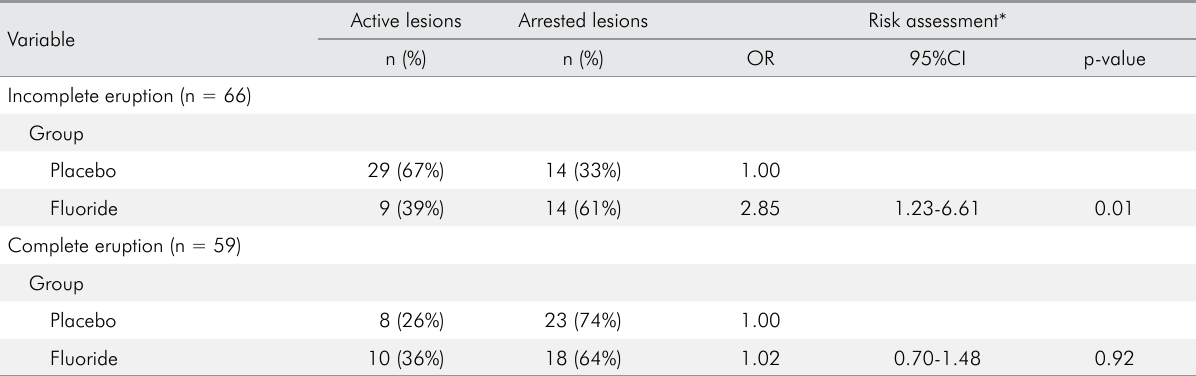
Table 4. Association between group and lesion arrestment including occlusal caries lesions on permanent molars stratified by stage of eruption (incomplete and complete). n = 125